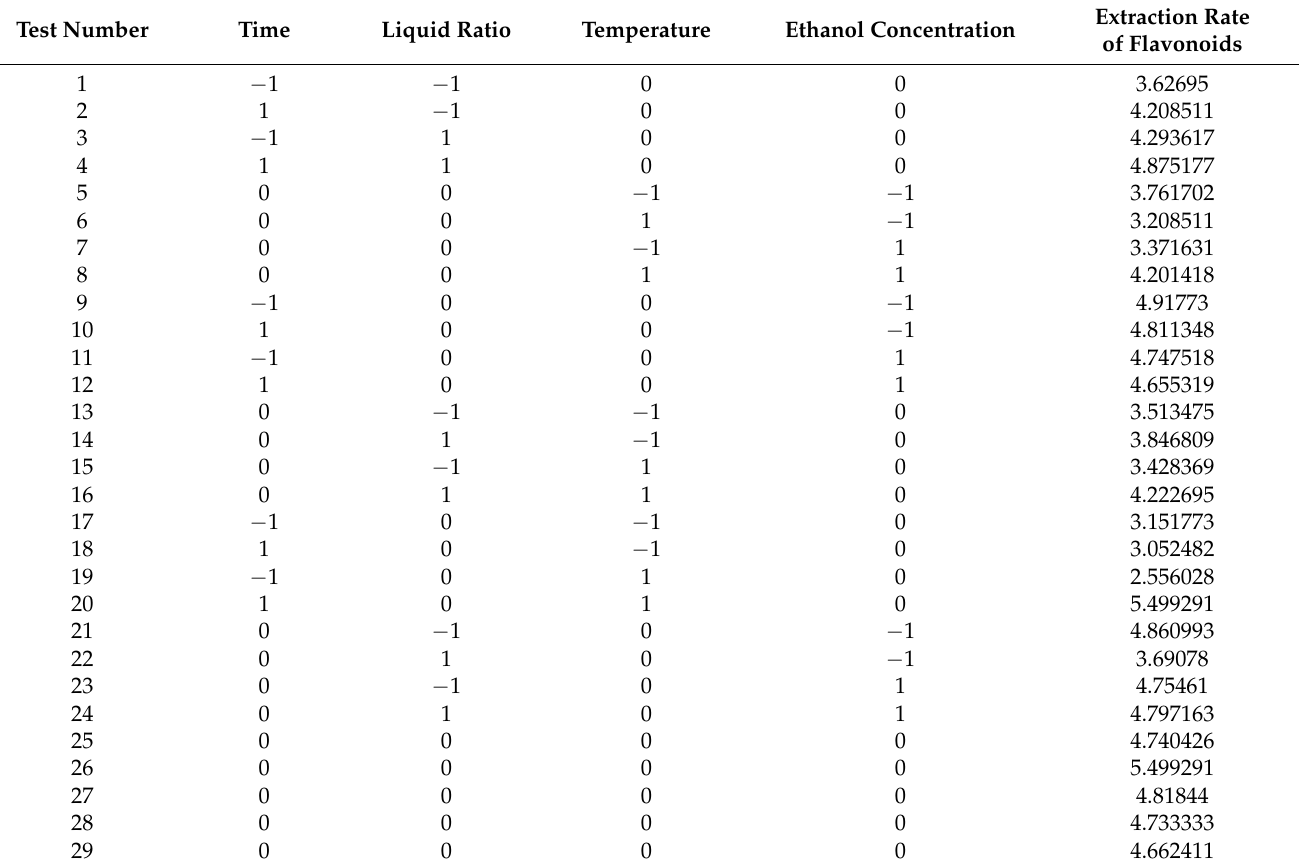
Table 1. Design Results of Boxed Behnken Center combined experiment for cotton